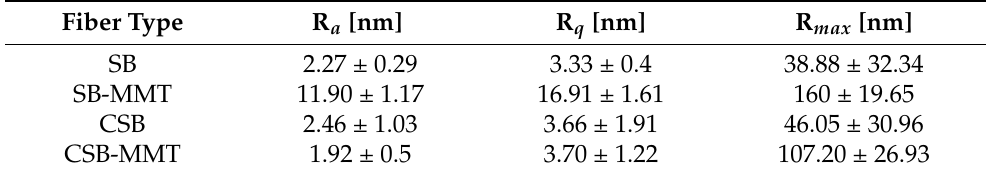
Figure 8. AFM images of IPF fibers coated with ( a ) SB, ( b ) CSB ( c ) SB-MMT, and ( d ) CSB-MMT. Table 2. Average roughness R a , square roughness R q , and maximum roughness R max values of fibers with SB, SB-MMT, CSB, and CSB-MMT coating, determined by